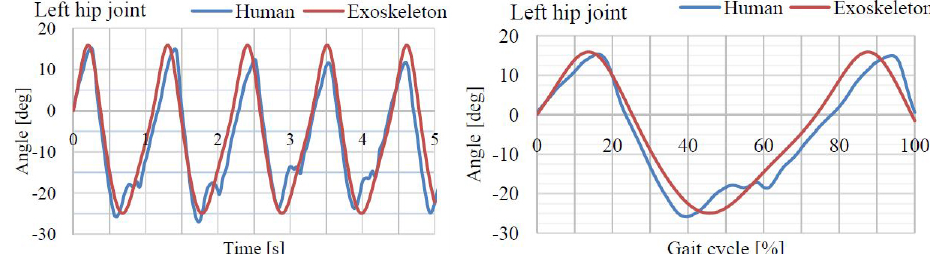
Figure 26. Compared variation of hip joint angle for human subject and for exoskeleton model.